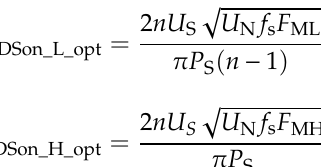
f s —switching frequency, F ML —figure of merit (7) for S1–S2, F MH —figure of merit (7) for S3–S8, P S —power of lower voltage side, for which value the minimum losses should